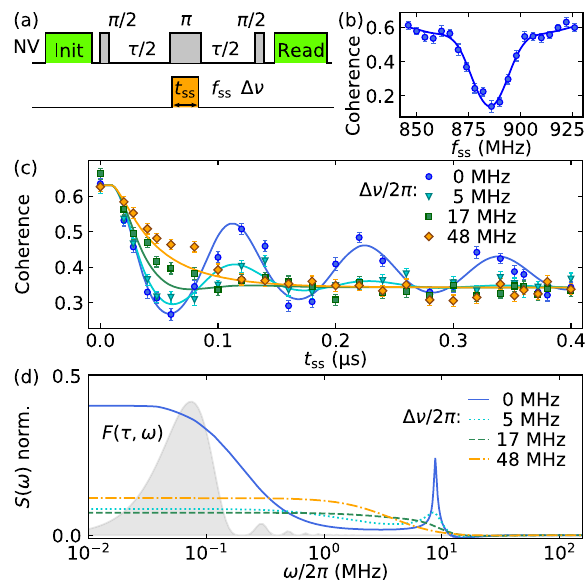
Fig. 3 Probing bath correlations to quantify noise spectrum under drive. a Pulse sequence used to probe the surface spin bath, and ( b ) corresponding spectrum with Δ ν = 0, t ss = 60 ns, τ = 20 μ s, π = 9.7 MHz, and an NV π -pulse of 80 ns. c Experimental spin Ω ss /2 bath dynamics, obtained by measuring NV coherence as a function of pulse length t ss for different excitation line-widths Δ ν and for Ω ss / 2 π = 8.7 MHz. Increasing Δ ν accelerates the damping of the Rabi oscillations, eventually reaching an overdamped regime. d Noise spectral densities obtained by Fourier transformation of the fi tted R 1 S ð ω Þ d ω = 2 π ¼ 1 . Gray DEER signals in ( c ) and normalized so that 2 0 shaded area represents the Hahn-echo fi lter function corresponding to a sequence duration of τ = 10 μ s. Error bars represent ± one standard